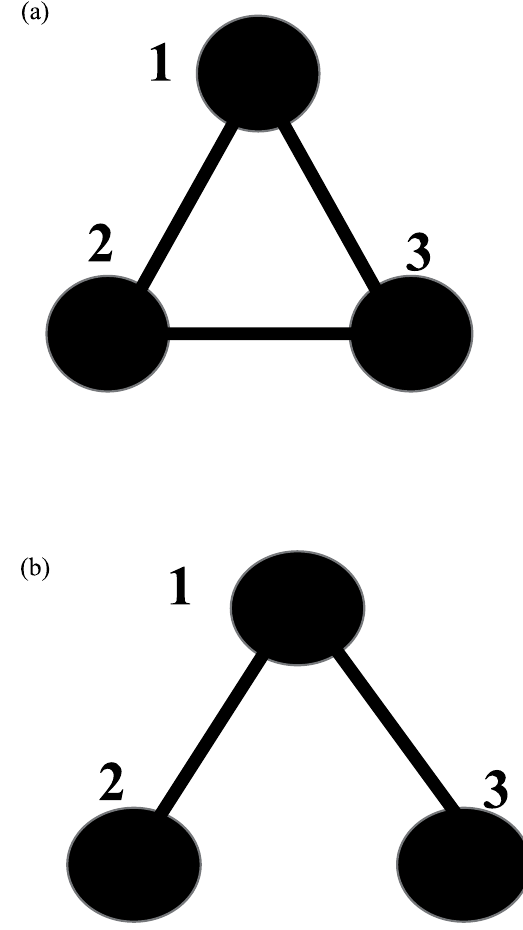
Figure 1. Schematic illustration of the metapopulation model ( N = 3). Each graph is composed of three subpopulations (nodes) 1, 2, and 3. Each line connecting a pair of nodes denotes the path (link). Two configurations are possible for N = 3. ( a ) Homogeneous graph: all nodes have the same degree (number of links). ( b ) Heterogeneous